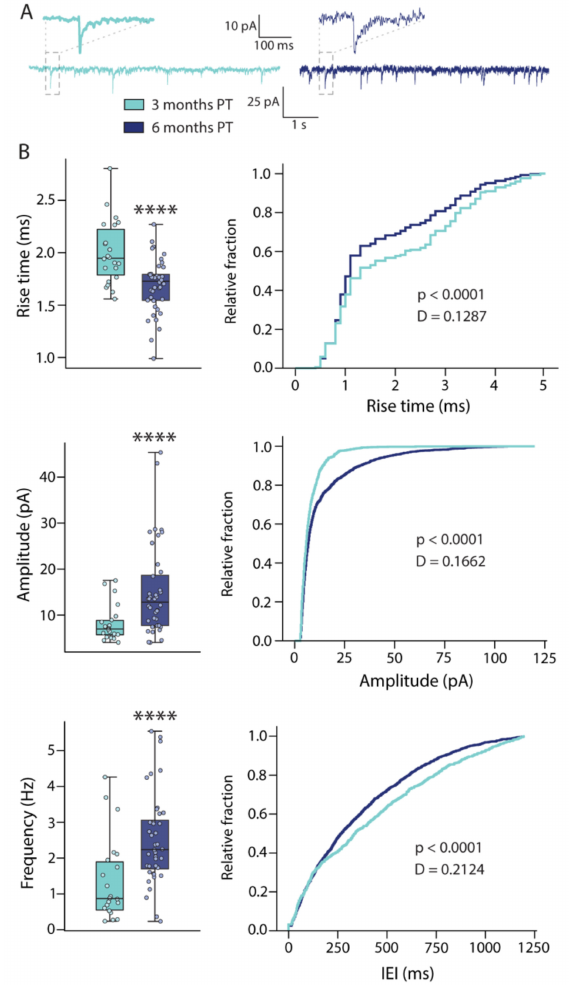
Figure 3. Spontaneous synaptic events in grafted hdInts. ( A ) Representative traces of voltage- clamp recordings from grafted hdInts in which sPSCs were detected. ( B ) Comparisons of sPSC characteristics between three- and six-months PT demonstrate the differences between medians and distributions. The rise time of the detected events is significantly shorter, amplitude significantly larger and frequency significantly higher at six months PT indicating improved synaptic integration at this later time point. ****, p < 0.0001. A Mann-Whitney test was used to compare medians in box plots, Kolmogorov-Smirnoff test was used for comparison of distributions. IEI, inter-event